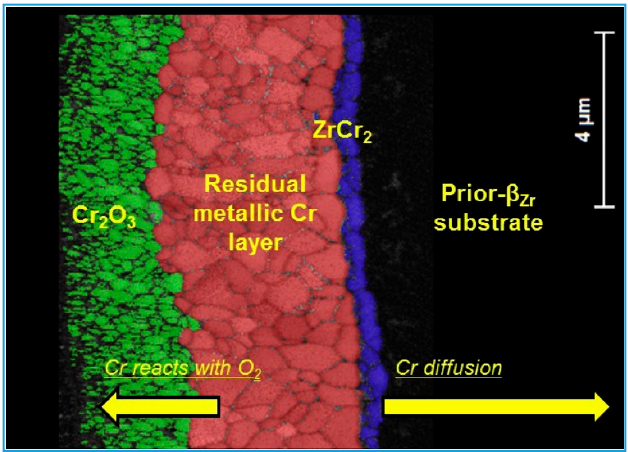
Figure 7. Phase evolution of the Cr-coated Zr alloy system during the high-temperature oxidation. Reproduced from the work in [2] with copyright permission from Elsevier.